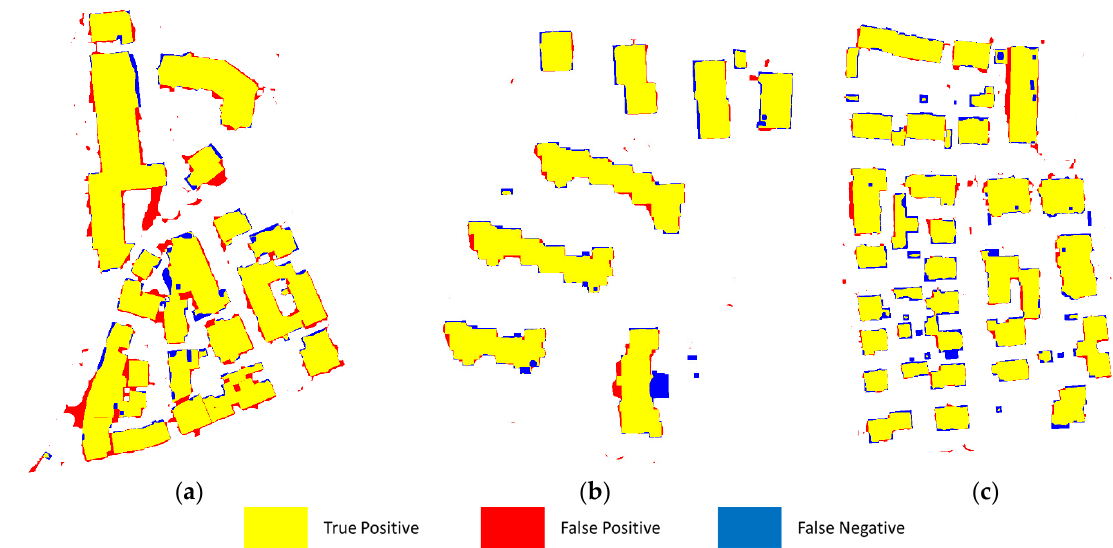
Figure 7. Evaluation of building detection outcome of our model against the ground truth data. The best SSL technique has been selected to train the model for each area. ( a ) Area 1 (WeiAve for SSL), ( b ) Area 2 (WeiAve for SSL), ( c ) Area 3 (SAFER for SSL).